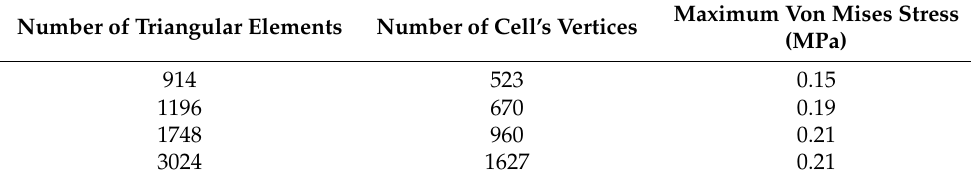
Table 6. Evolution of the maximum value of Von Mises stress near the chip edge in contact with the PCB.